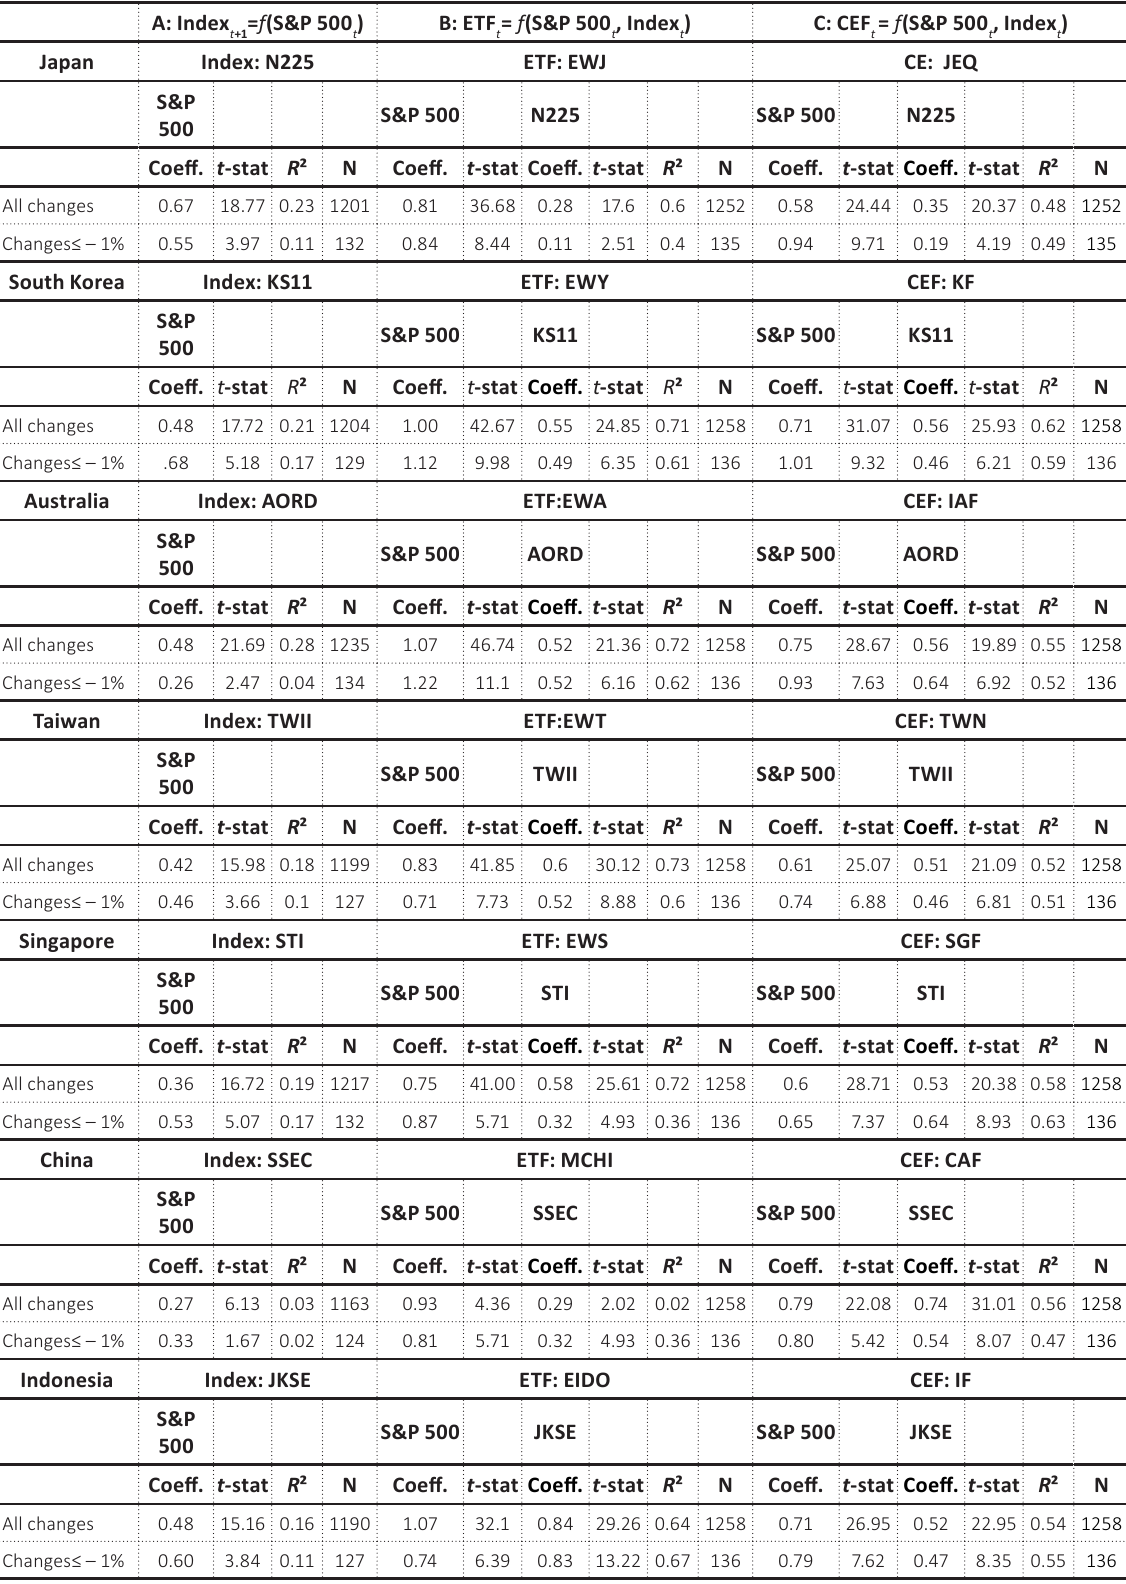
Table A1. 2011–2015 daily return impact of S&P 500 changes on foreign index, ETF and CEF